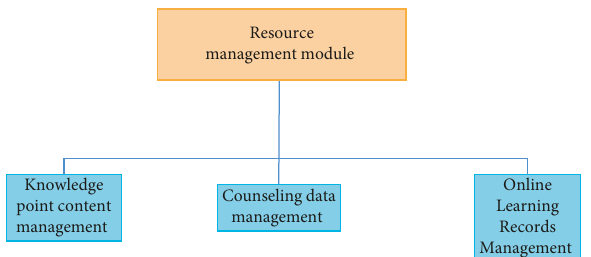
Figure 4: Schematic diagram of resource management module.